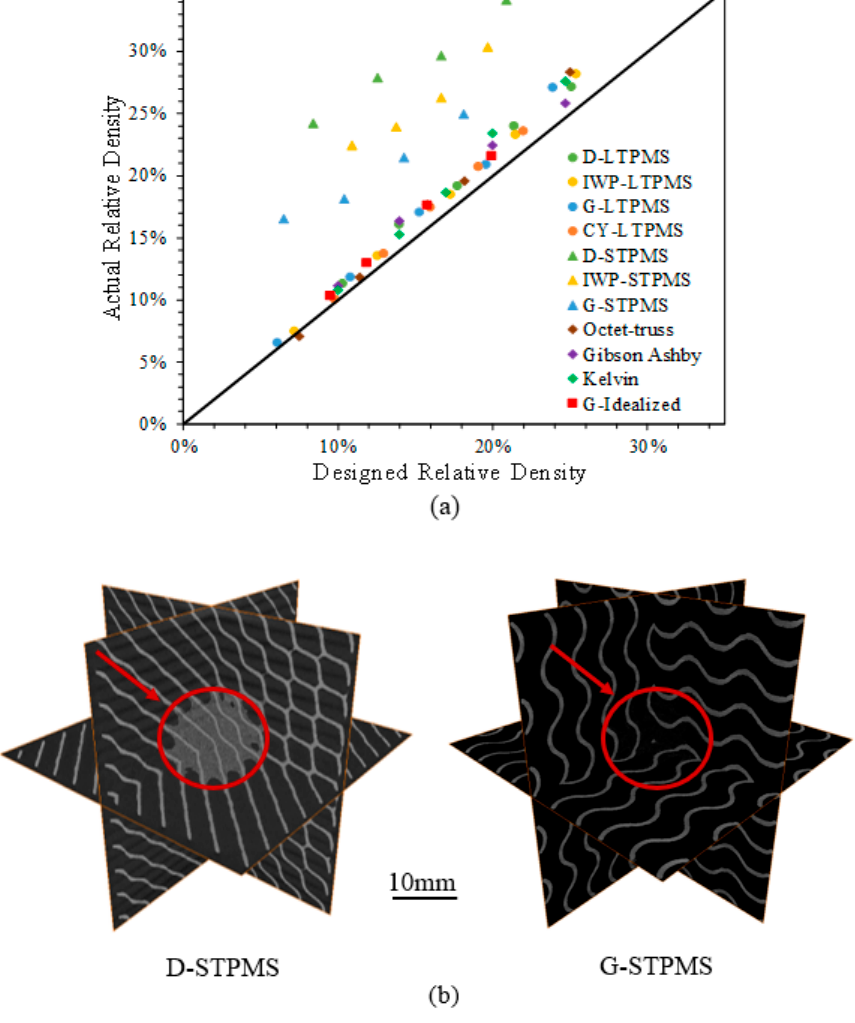
Figure 4. ( a ) Designed versus measured relative density for the sheet-based TPMS, ligament-based TPMS, and strut-based lattices. ( b ) CT scan images of 3D orthogonal slices showing the loose powder for the D-STPMS (8.4% designed RD and 24.2 ± 1.7% measured RD) and G-STPMS (18.2% designed RD and 25.0 ± 0.2% measured RD). Table 3. Designed versus measured RD for the strut-based lattices.